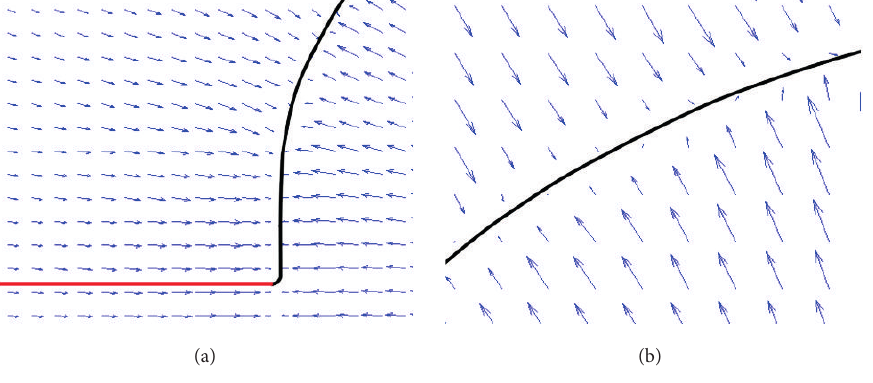
Figure 3: The locally enlarged regions of external force